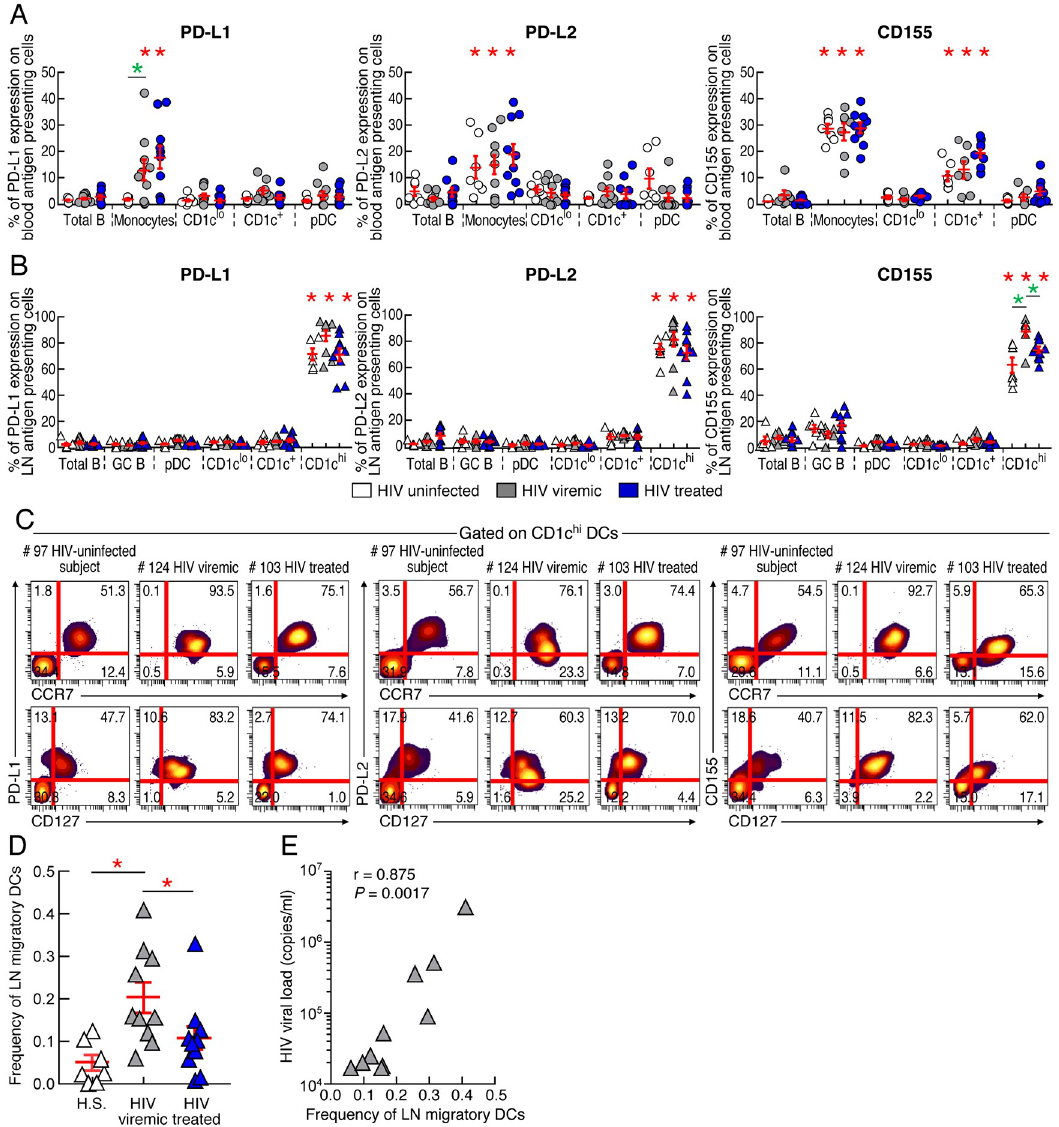
Fig 2. PD-L1, PD-L2 and CD155 are predominantly expressed on blood monocytes and lymph node migratory dendritic cells. (A) Percentage of PD-L1, PD-L2 or CD155 expression on blood (A) or LN (B) mononuclear-cell populations of HIV-uninfected (N = 7), viremic (N = 10) and aviremic ART treated HIV-infected individuals (N = 10). (C) Levels of IC-L expression on LN CD1c high DCs expressing CCR7 and/or CD127 of a representative HIV-uninfected (#97), viremic (#124) and aviremic ART treated HIV-infected individual (#103). (D) Frequencies of LN migratory (CD1c high CCR7 + CD127 + ) DCs in HIV-uninfected (N = 7), viremic (N = 10) and aviremic ART treated HIV-infected individuals (N = 10). (E) Correlation between the levels of HIV viral load and the frequencies of LN migratory DCs in viremic HIV-infected individuals (N = 10). White symbols correspond to HIV- uninfected subjects, grey corresponds to HIV-1 viremic individuals and blue symbols correspond to HIV-infected aviremic ART treated individuals (A-B, D-E) . Blood cell populations are represented in circles (A) . LN cell populations are represented in triangles (B, D-E) . Red bars correspond to mean ± SEM (A-B, D) . Red stars indicate statistical significance ( P < 0.05) for intra-group comparisons (A-B, D) whereas green stars indicate statistical significance ( P < 0.05) for inter-population comparisons (A-B) . Statistical significance ( P values) was obtained using one-way ANOVA (Kruskal-Wallis test) followed by Mann Whitney test (intra- group comparisons) or Wilcoxon Matched-pairs two-tailed Signed Rank test (inter-population comparisons) or using Spearman rank test for correlations (E) .